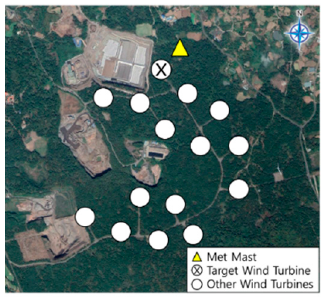
Figure 1. The layout of wind farm D (Source: Google Maps).